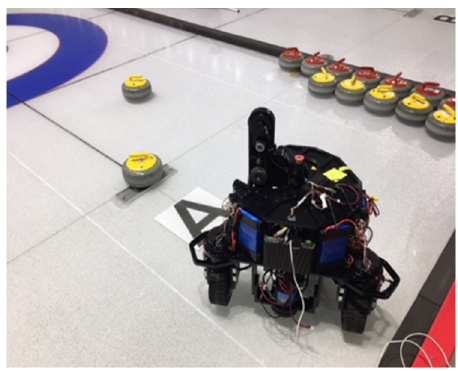
Figure 6. Experiment on curling stone measurements in an actual curling field.